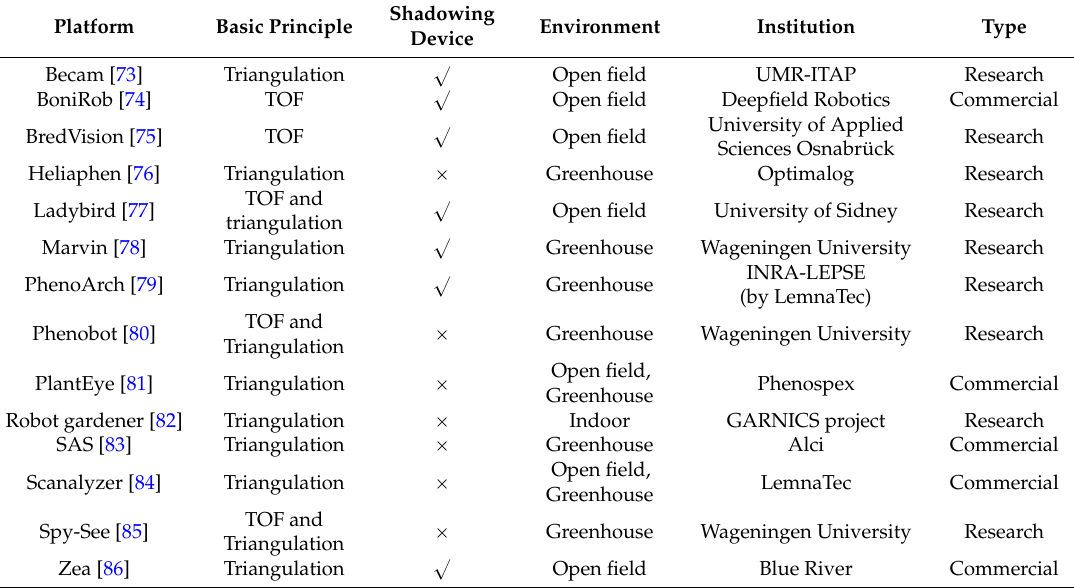
Table 3. Autonomous platforms for reducing the time-consuming and repetitive phenotyping